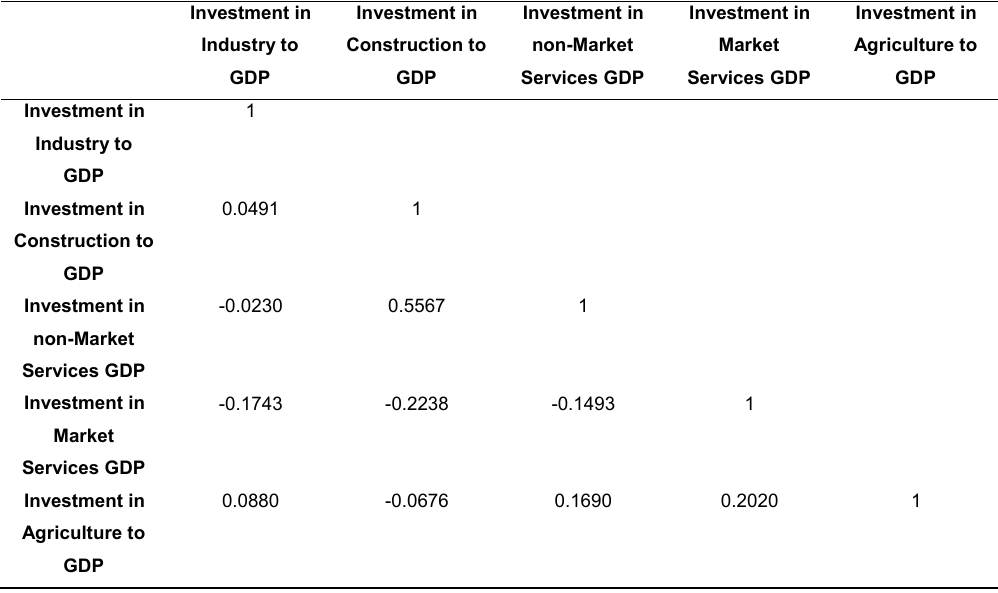
Table 10 . Pairwise correlations between classes of investment rates.